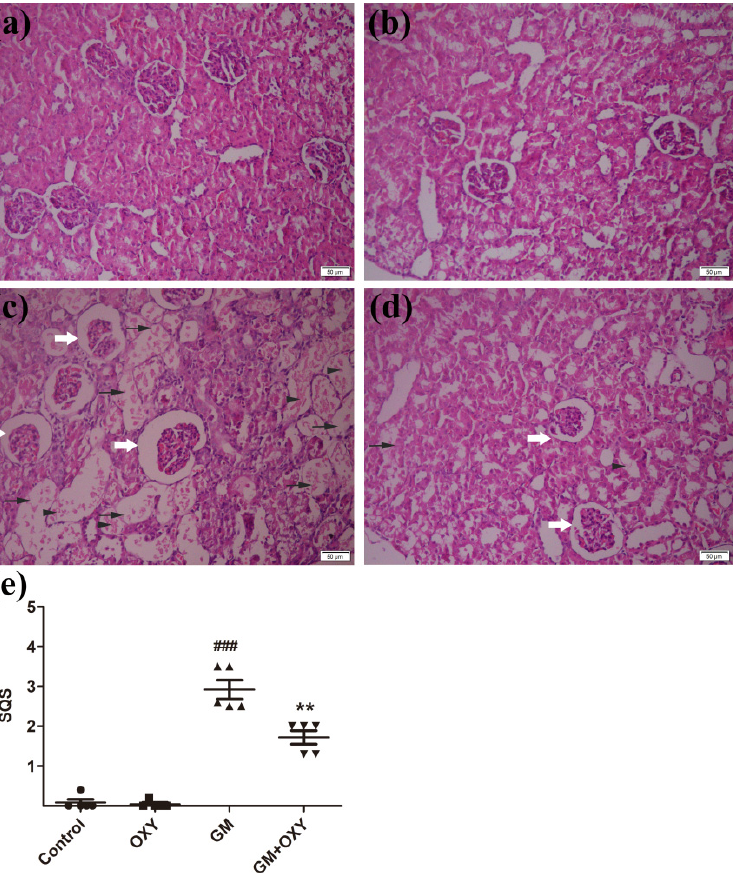
Figure 2. ( a ) Control group: no significant damage. ( b ) Oxymatrine group: no significant damage. ( c ) Gentamicin group: marked tubular damage with necrosis and exfoliation of epithelial cells (ar- rows), cast formation (arrowheads) and glomerular abnormalities (open arrow). ( d ) Gentamicin + Oxymatrine group: minor tubular with necrosis (arrows) of epithelial cells, cast formations (arrow- heads) and glomerular abnormalities (open arrow). ( e ) Semiquantitative scores of kidney damage (group the means ± SD, n = 5). ▲ indicated specimens, ### indicated. The scores are significantly higher in GM + OXY, p < 0.001 compared to the control group (indicated as ### ) and significantly lower than GM group (indicated as **) p < 0.01 and p < 0.001. OXY inhibited gentamicin-induced renal inflammatory responses.